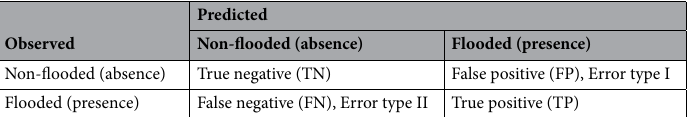
Table 5. Contingency table used for evaluating